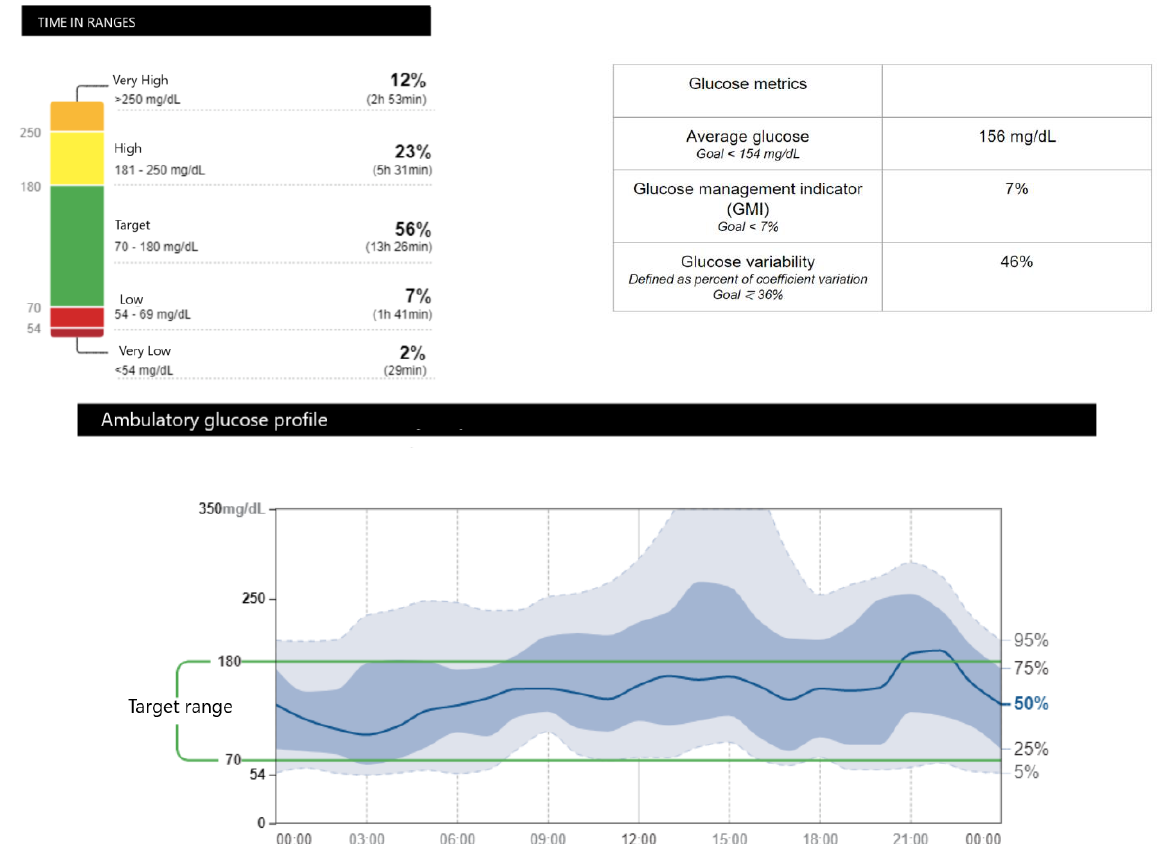
Figure 2. Ambulatory glucose profile (AGP) report of continuous glucose monitoring (CGMS) in a patient with total pancreatectomy due to an 8 × 6 × 7.5 cm pNET.